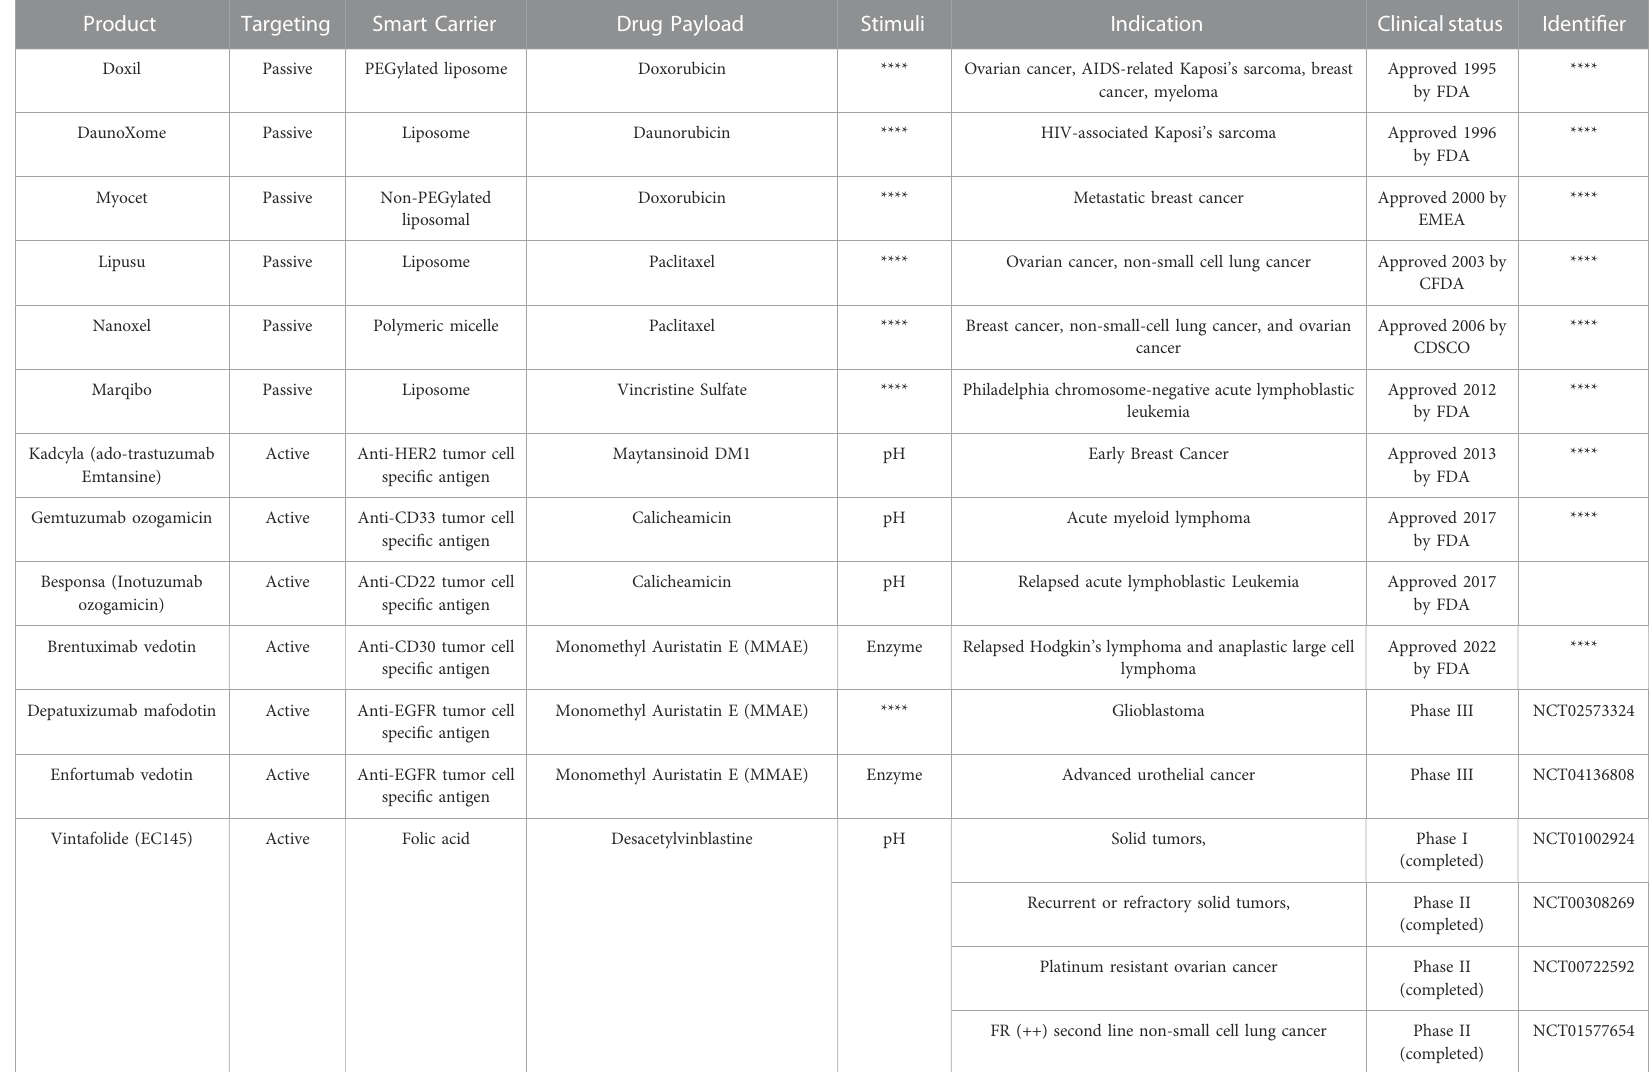
TABLE 2 Some medicines for cancer treatment based on SDDSs that are in clinical trials or already